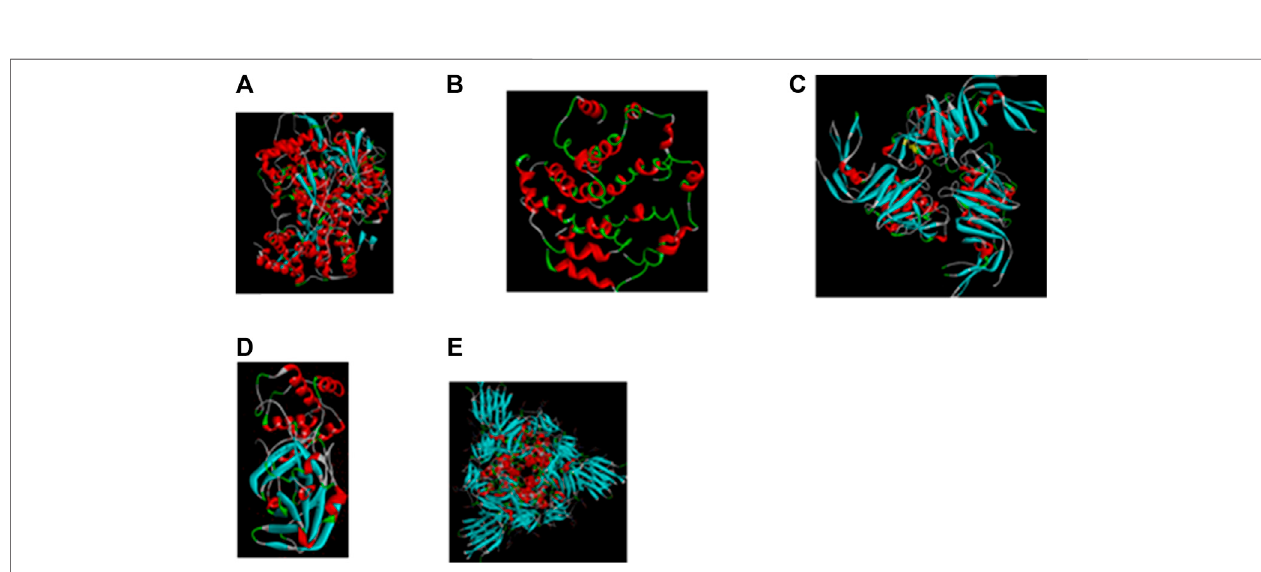
FIGURE 2 | Important molecular targets in SARS-CoV2 structure for interaction with antiviral compounds in phytomedicines. Many African herbal solutions are polyherbal with potentials for more than one therapeutic targets on the viral particle (A) PDB 6M71: Structure of the RNA-dependent RNA polymerase from COVID-19 virus (Gao et al., 2020); (B) PDB 5X29: NMR structure of the SARS Coronavirus E protein pentameric ion channel (Surya et al., 2018); (C) PDB 6W9C: The crystal structure of papain-like protease of SARS CoV-2 (Walls et al., 2020); (D) PDB 6MQ: SARS-CoV-2 3CL protease (3CL pro) apo structure (Su et al., 2010); (E)